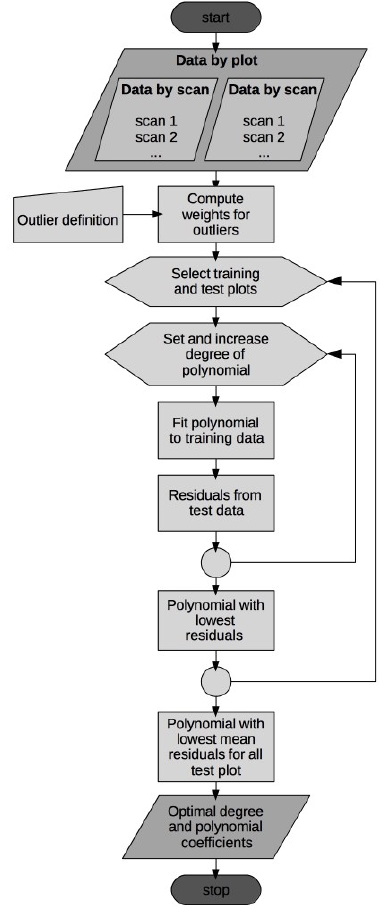
Figure 1. The procedure for optimizing the polynomial